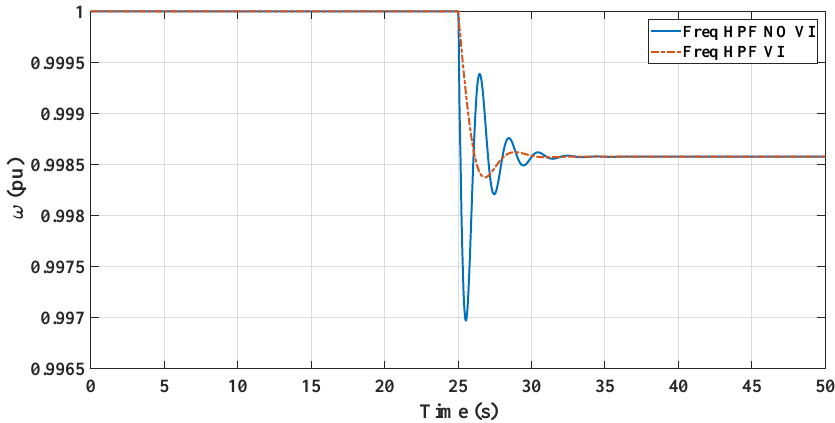
Figure 15. Frequency response comparison when dynamic loads increased by 3%.